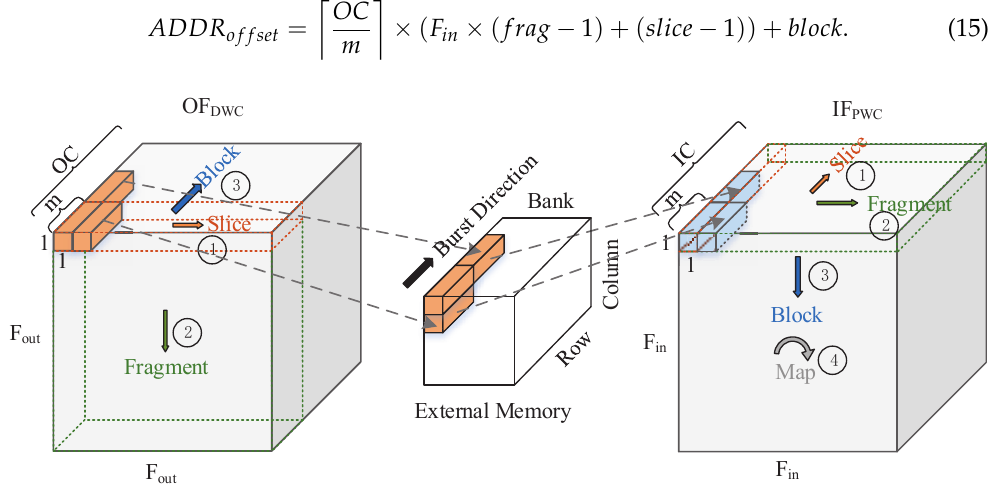
Figure 8. The address mapping between the output unit of DWC PUDL and the input unit of PWC PUPL